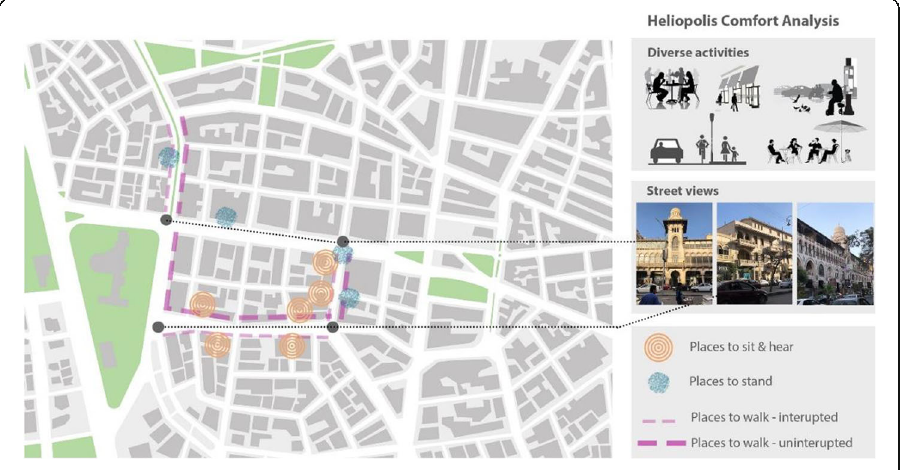
Fig. 5 Heliopolis map, Analysis of Comfort aspect in Roxy and Korba Street